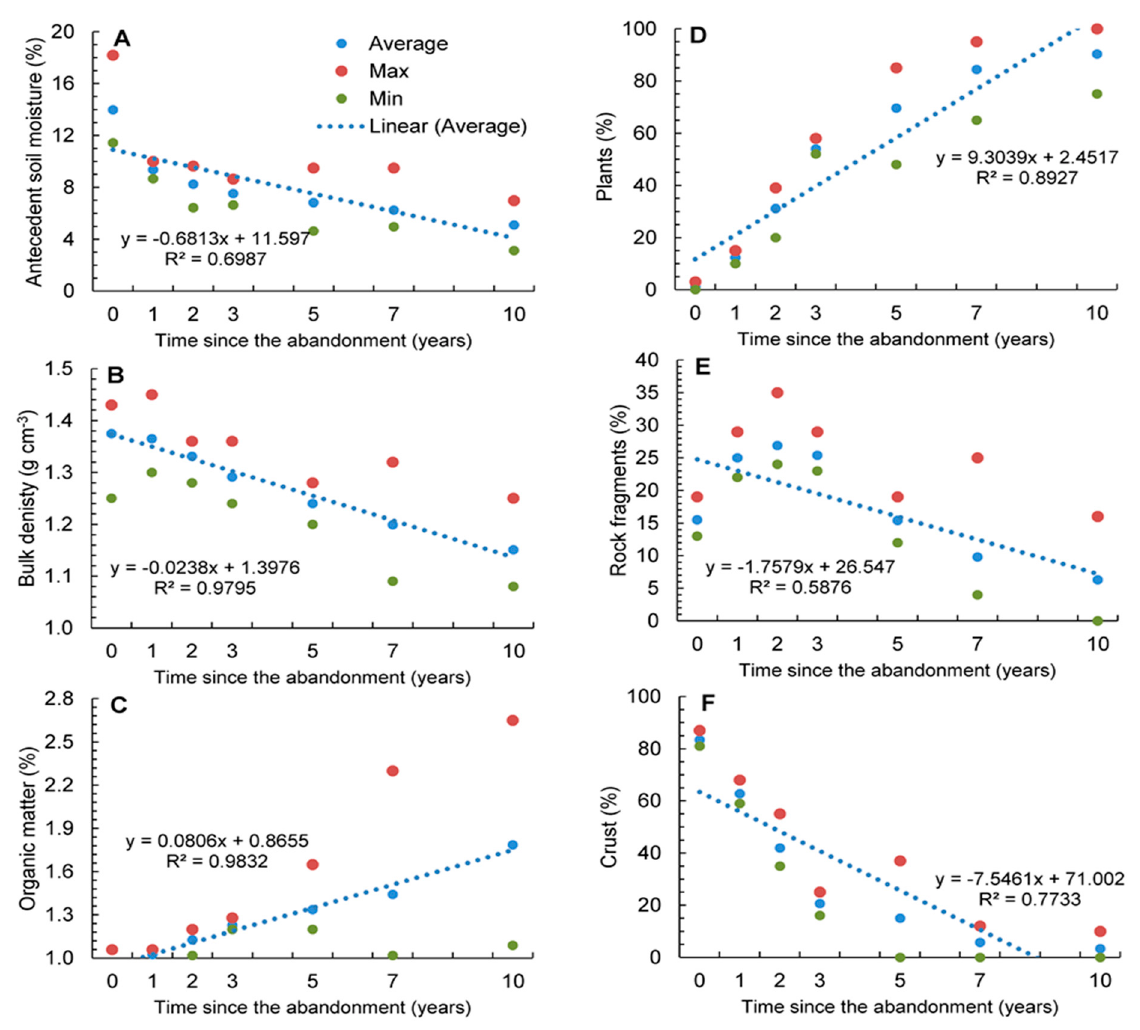
Figure 2. Variation of soil properties over different time periods since abandonment. ( A ) Antecentt soil moisture; ( B ); Bulk density; ( C ); Organic matter; ( D ); Plants; ( E ) Rock fragments; ( F ) Crust.